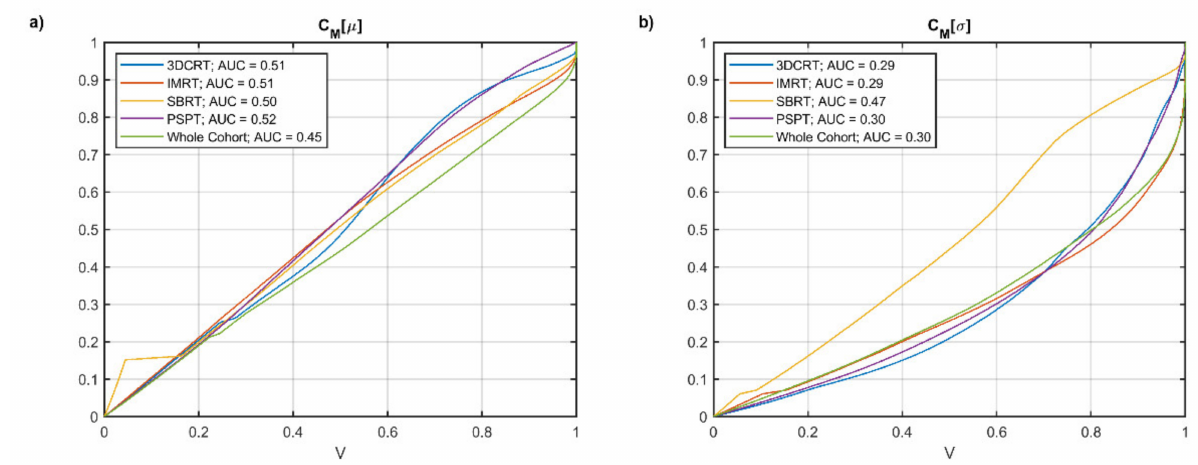
Figure 2. Plots of C M [ µ ] ( a ) and C M [ σ ] ( b ) as function of the fractional volume V for the different groups of patients and the entire